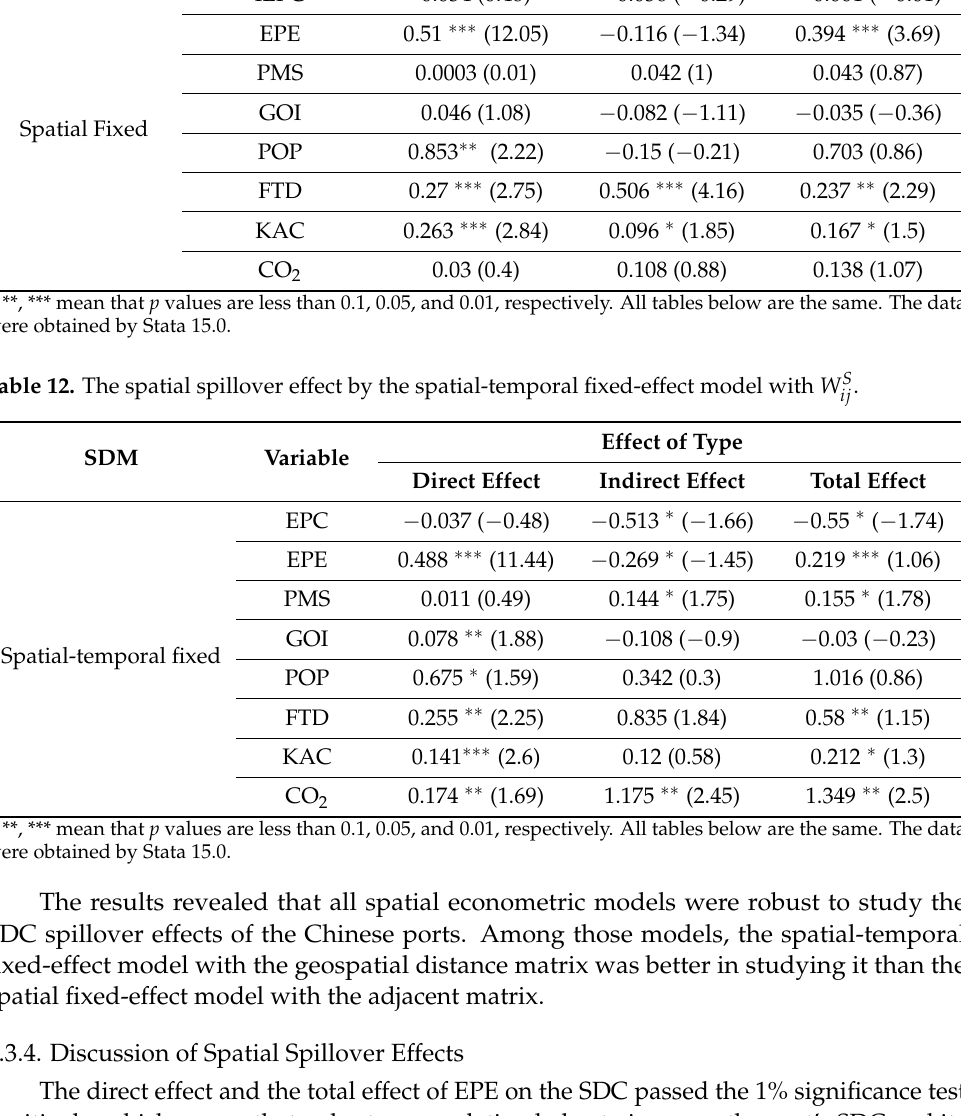
Table 11. The spatial spillover effect by the spatial fixed-effect model with W A